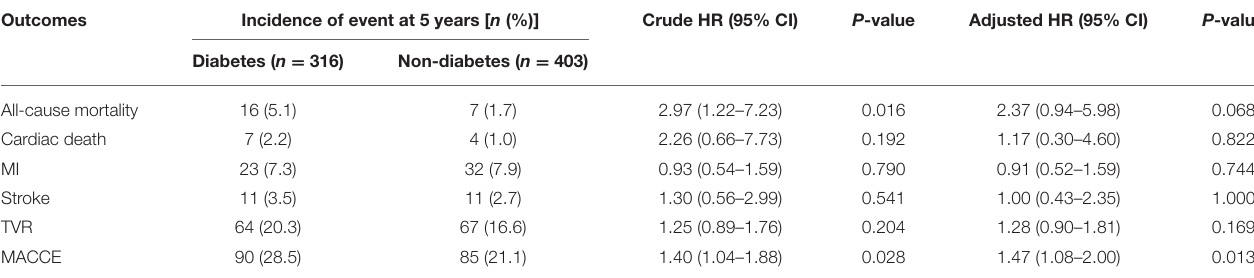
TABLE 3 | Risk of various clinical outcomes up to 5 years in all patients. Outcomes